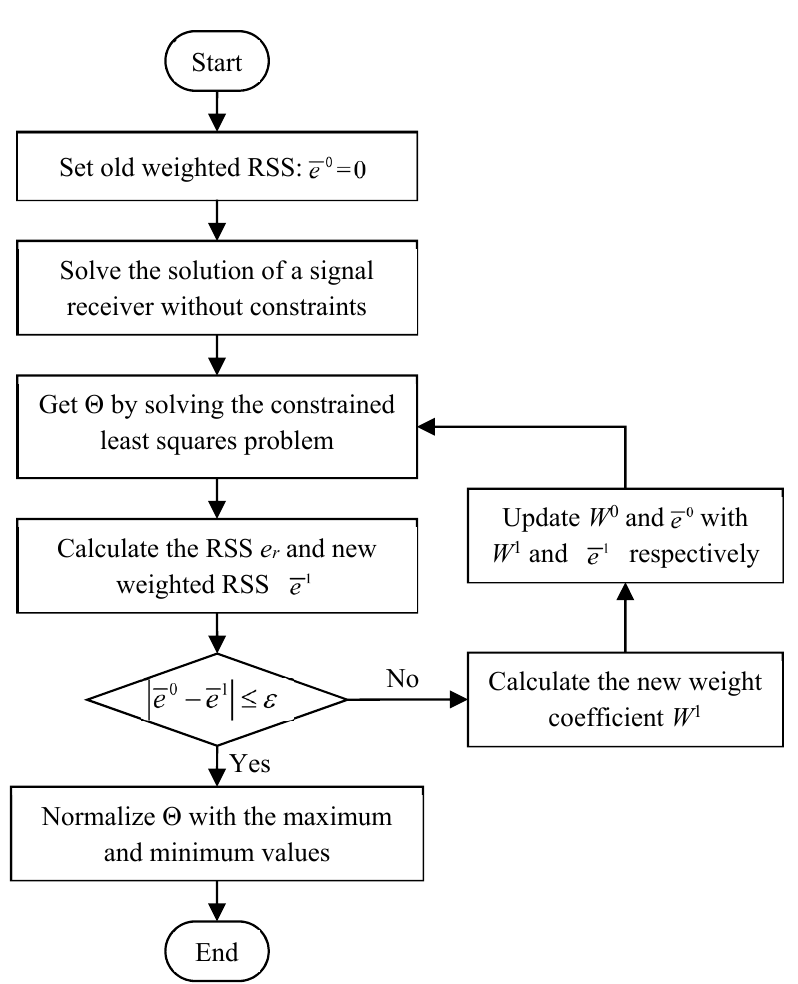
Figure 4. Flowchart of the improved learning method with self-adaptive weights for touch localization. In this method, the residual sum of squares (RSS) is used to update the weight coefficient. The initial locating results: Θ 0 is obtained by solving Equations (6)–(8)